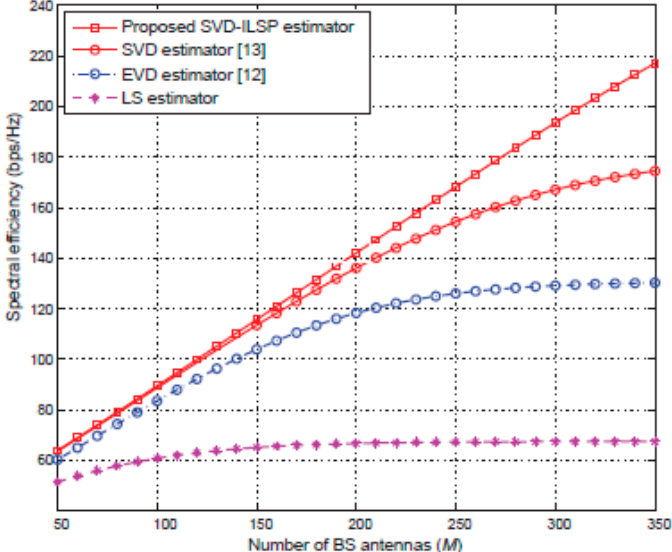
Figure 7. Spectral efficiency comparison of algorithms under a different number of base station antennas.